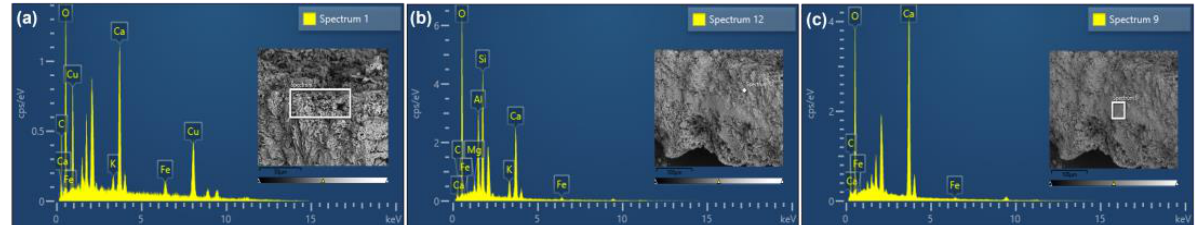
Figure 7. Scanning electron microscope (SEM) image of a part of mural sample. ( a , b ) Whole. ( c ) details. ( d ) details of painting layer. ( e ) details of ground layer.